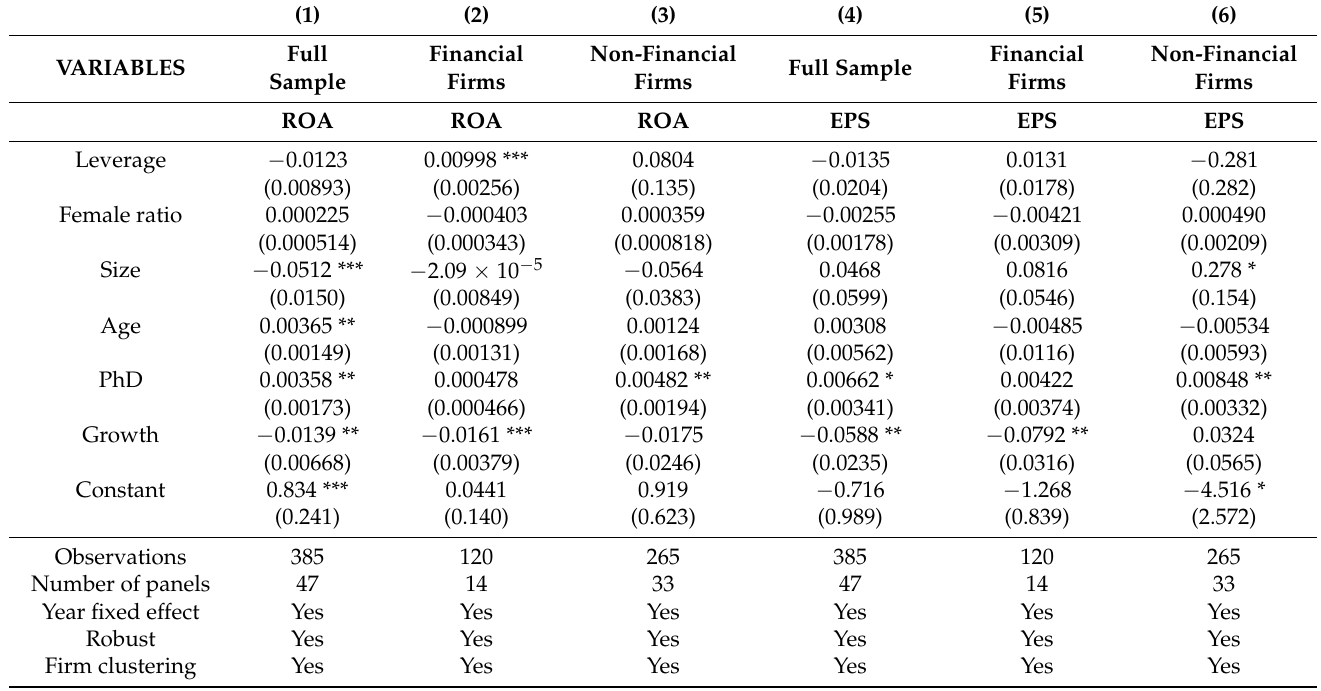
Table 7. The linear impact of gender diversity in BOD on ROA and